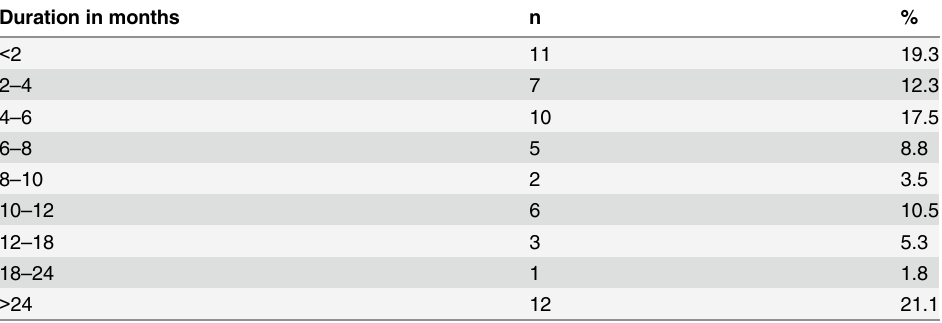
Table 2. The duration of chronic sequelae reported by 57 individuals following acute